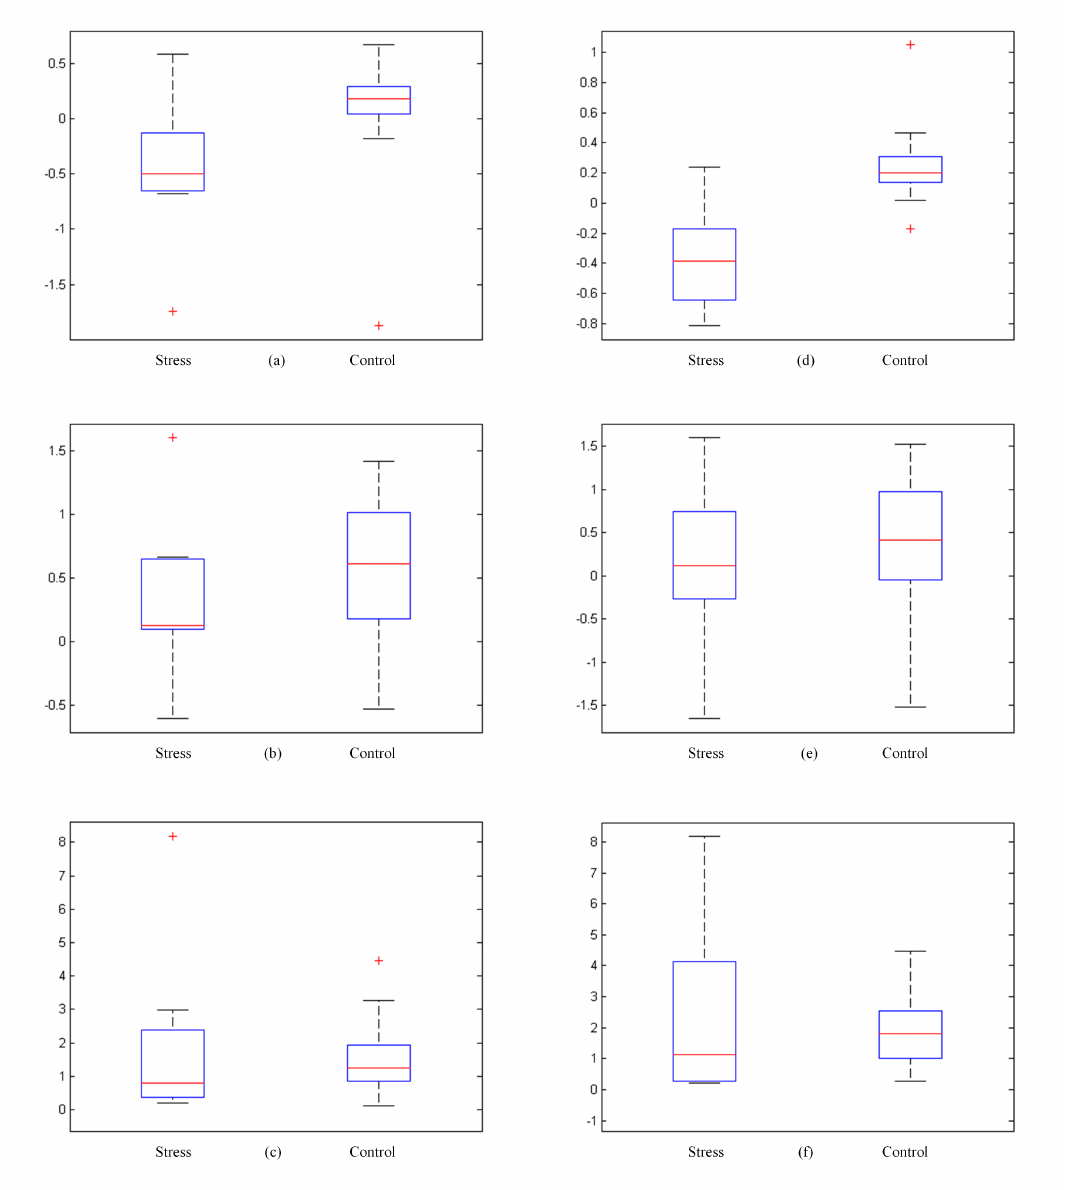
Figure 5. Box plots of features. ( a ) Alpha asymmetry; ( b ) beta; ( c ) gamma; ( d ) alpha asymmetry (EE); ( e ) beta (EE); ( f ) gamma (EE); EE represents the labeling method of expert